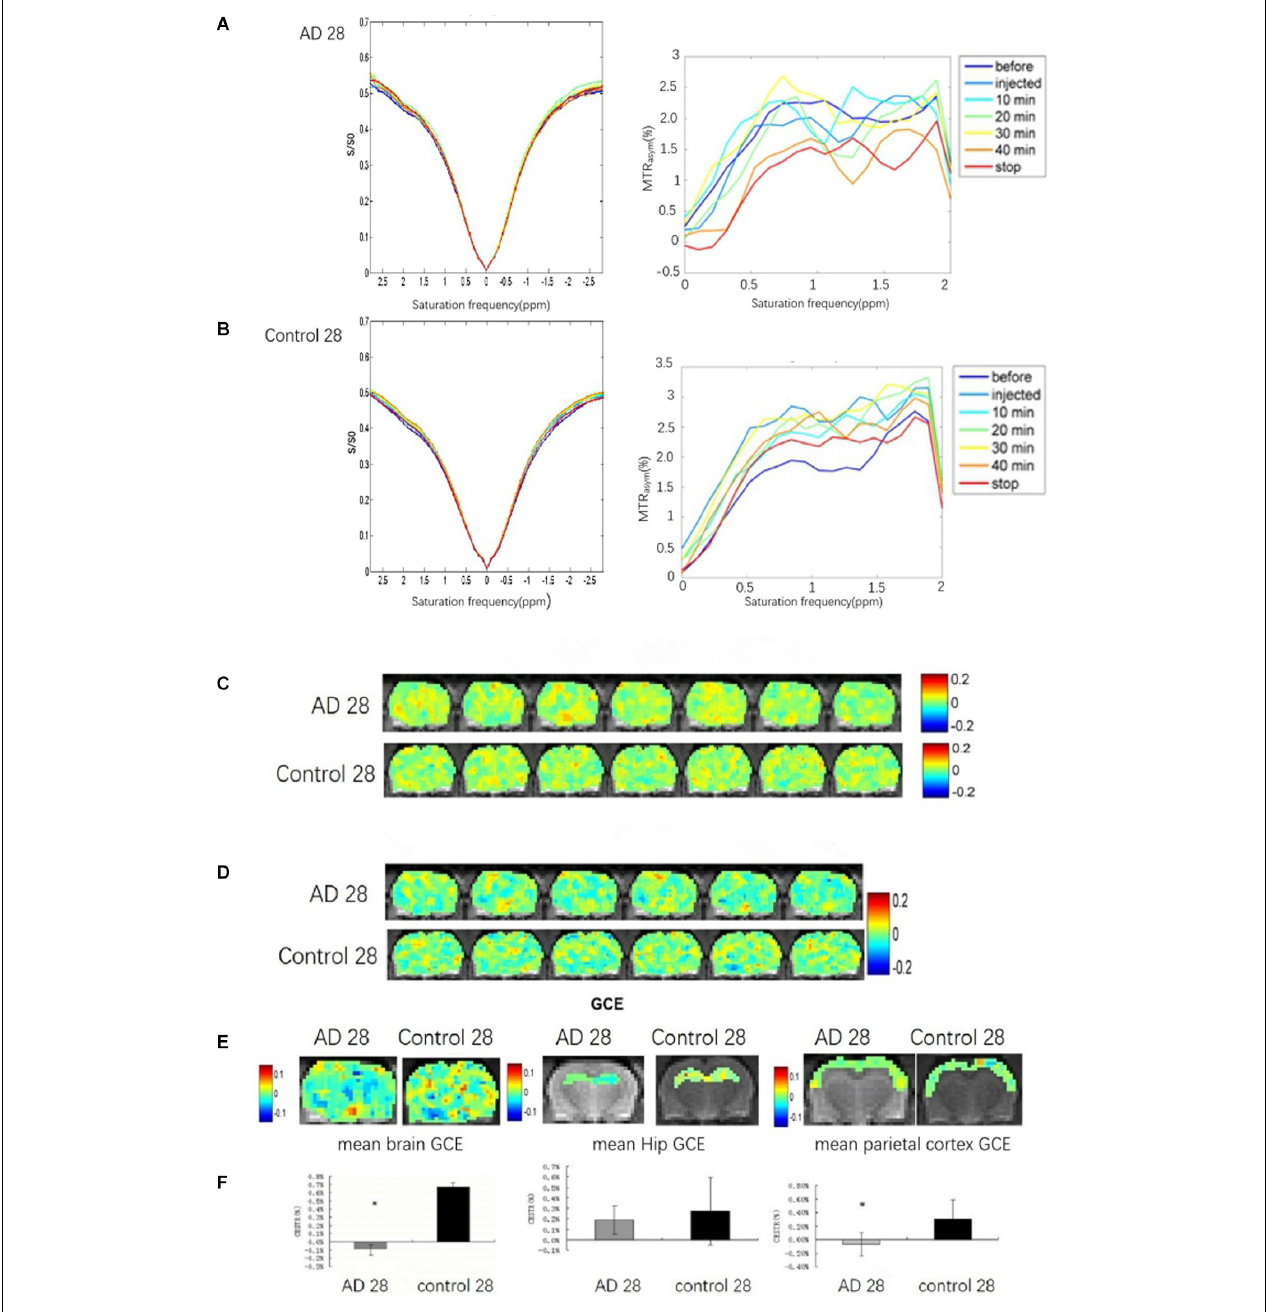
FIGURE 3 | The brain GCE signal of a rat in AD and control groups at 28 days after A β 25–35 administration, respectively. (A,B) Showing Z-spectra and MTR asym of AD and control rat brains. (C,D) Showing glucoCEST and GCE images of AD and control rat brain at 28 days after A β 25–35 administration in specific time point, respectively. (E) The mean GCE signal of the total brain, hippocampus, and parietal cortex in an AD rat and a healthy rat. (F) The corresponding bar chart to the mean GCE signal of the total brain, hippocampus and parietal cortex in AD and control rats. It indicates that the glucose uptake of the whole brain in AD rats was significantly decreased, P < 0.05; the glucose uptake of the AD rats hippocampi is reduced, but p > 0.05; the glucose uptake of the parietal cortex in AD is decreased, p < 0.05 (* p < 0.05, error bar was standard error).